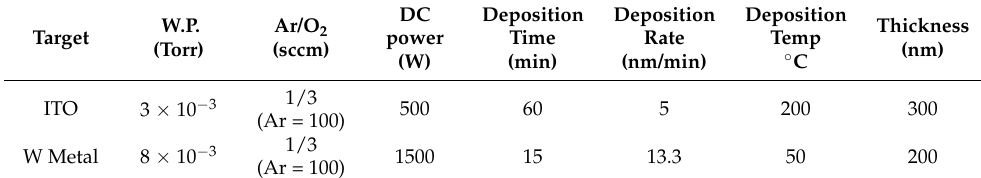
Table 2. Deposition parameters of transparent ITO glass and WO 3 electrode film.